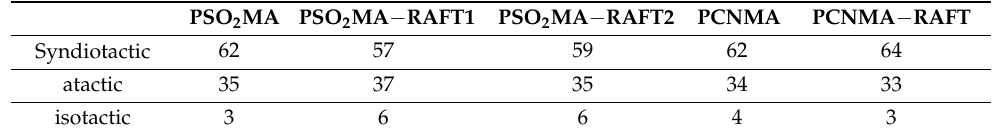
Table 1. Tacticity values (%) of obtained polymethacrylates.